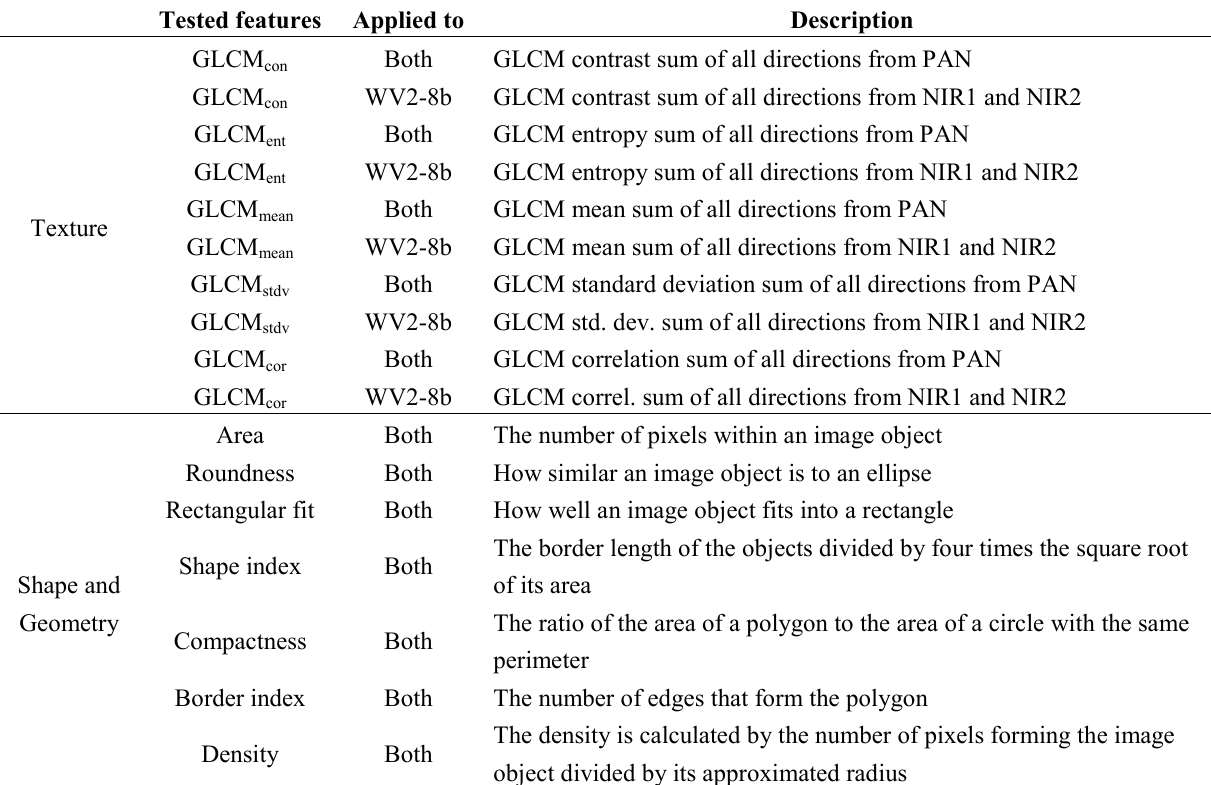
Table 4. Image object features based on texture, shape and geometry used in the classification phase. More information about these features can be found in [42]. GLCM, gray-level co-occurrence